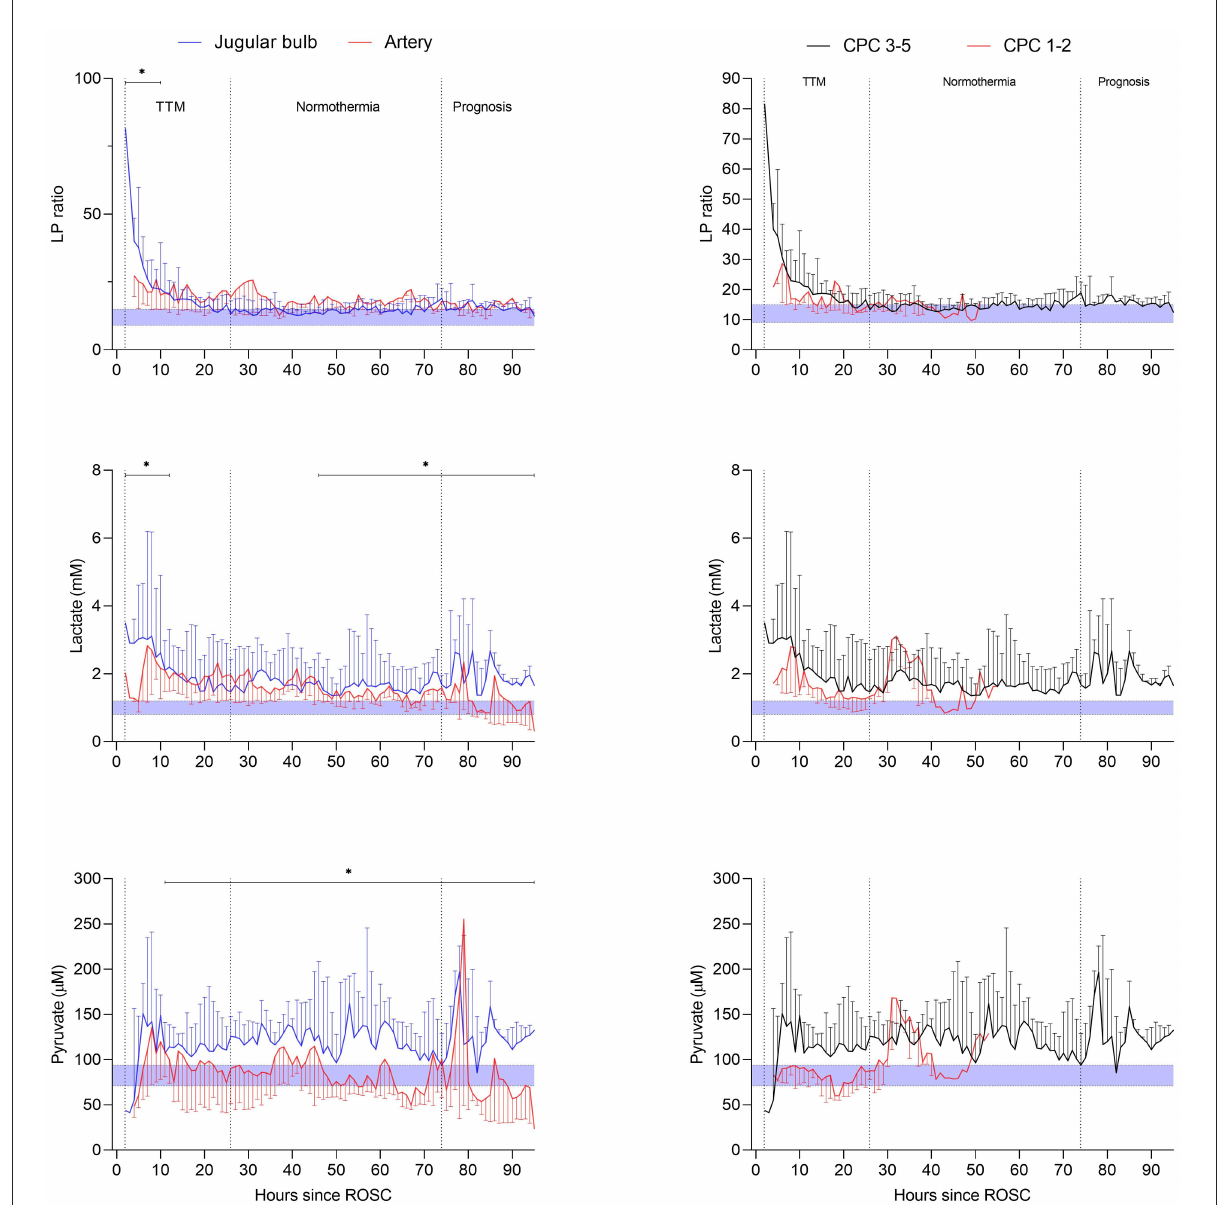
FIGURE13 Left panels: microdialysis variables (LP ratio, lactate, pyruvate) of the jugular venous and arterial blood during post-resuscitation care after out of hospital cardiac arrest in patients with unfavorable outcome. Right panels: jugular bulb microdialysis variables (LP ratio, lactate, pyruvate) during post-resuscitation care in patients with unfavorable outcome (CPC 3–5) compared with patients with favorable outcome (CPC 1–2). The period of targeted temperature management (TTM) is indicated in the figures. The difference between time-averaged means (in intervals of 12h) of LP ratio, lactate, pyruvate, glycerol and glutamate of the jugular venous and the arterial blood was significant during post-resuscitation care ( * p < 0.02) when using mixed effects models. Data are shown as median (IQR). Shaded areas represent normal reference levels for the variables during jugular bulb microdialysis (43). Figures by permission from